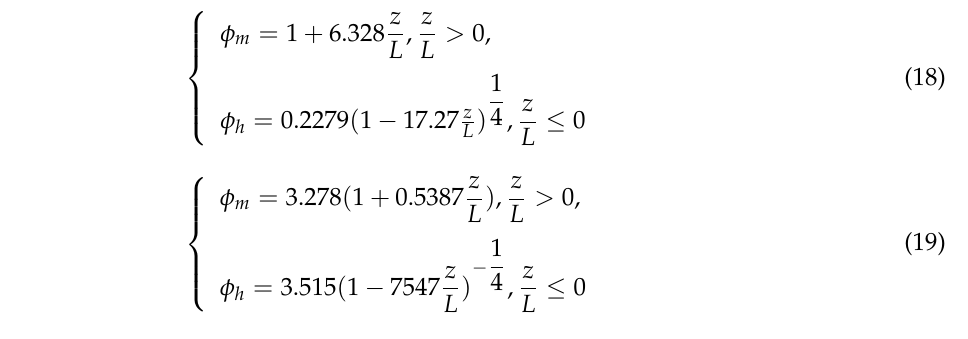
Figure 3. ( a ) Observed and calculated functions of ϕ m against z / L . ( b ) Same as ( a ) but for ϕ h . The relationships between ϕ m , ϕ h , and z / L in the NNE–ESE wind direction were obtained as follows (Equations (18) and (19)), where these coefficients are based on the least square fits.